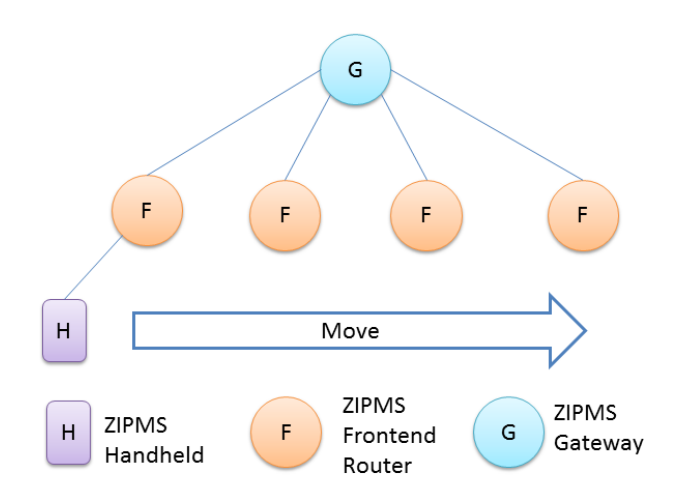
Figure 10. Experimental